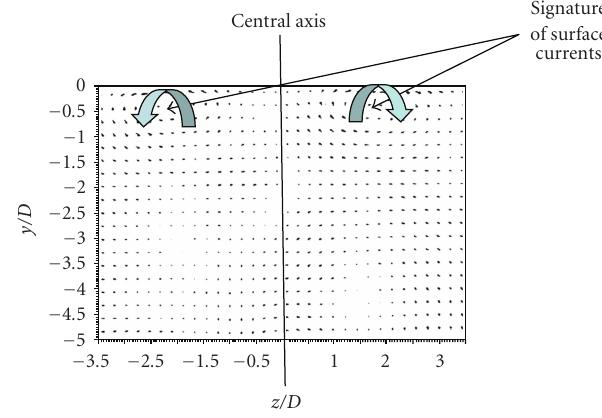
Figure 3: Signature of the surface currents as seen in a plane normal to the streamwise direction downstream of a blu ff